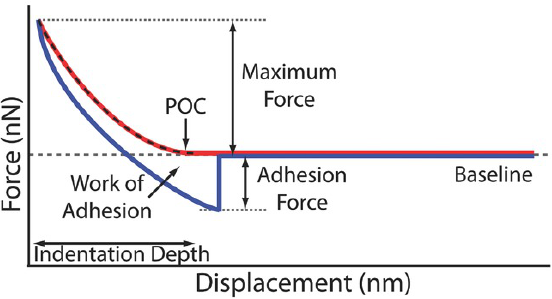
Figure 6. Schematic diagram of the adhesion in AFM nanoindentation, in which the red line is the approach and the blue line is the retract curve. Reproduced with permission from [86].